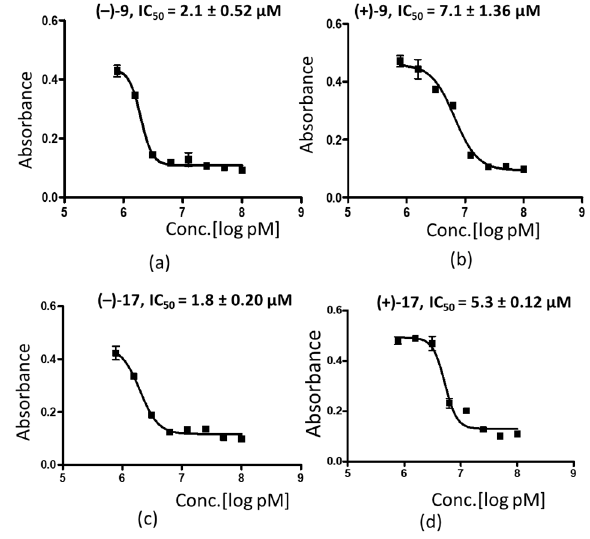
Figure 2. Antiplasmodial activity of the enantiomers of compounds 9 and 17 on P. falciparum. Logarithmic dose response curves for the testing of the enantiomers ( a ) (–)- 9 , ( b ) (+)- 9 , ( c ) (–)- 17 and ( d ) (+)- 17 on the P. falciparum 3D7 strain. Ring stage parasites were cultured with the compounds at concentrations of 100 µM to 0.78 µM for 72 h at 37 °C. CQ served as control. The viability of the parasites was determined by measuring the plasmodial LDH activity using the Malstat assay, and the absorbance of the photometric reaction was measured at OD 630 nm. The figures are representative of one of three independent experiments.